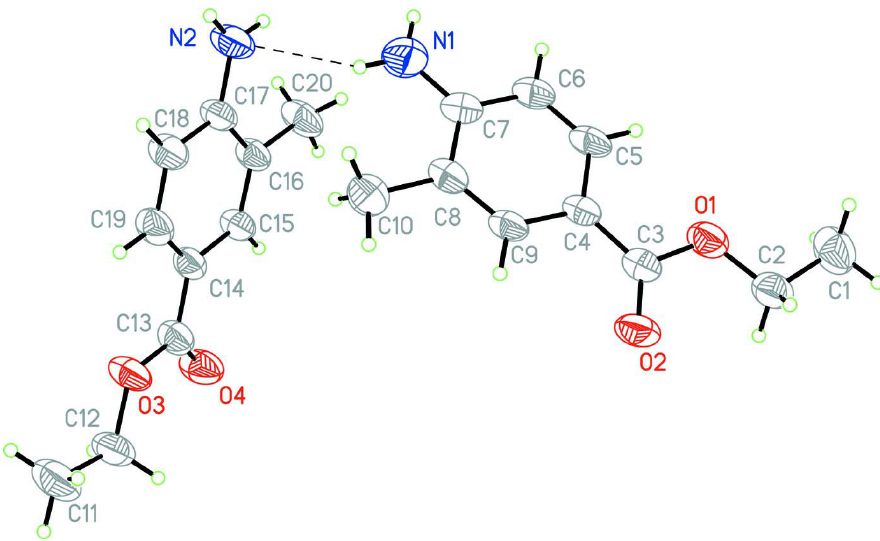
Figure 1 A view of the molecular structure of (I), showing displacement ellipsoids at the 50% probability level. N—H···N hydrogen bonds are shown as dashed